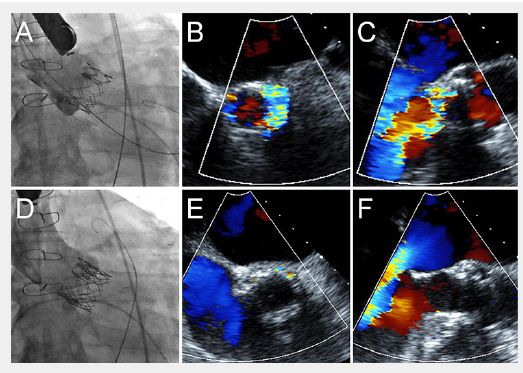
Treatment of paravalvular regurgitation by implantation of a second transcatheter heart valve. In patient, the TEE measured an annulus of 22 mm. A 26 mm Edwards Sapien XT valve was implanted (A). A low implantation resulted in severe paravalvular aortic regurgitation (B, C). A second 26 mm valve was subsequently implanted in a higher position, thus extending the annular seal (D) resulting in a mild paravalvular leak (E,